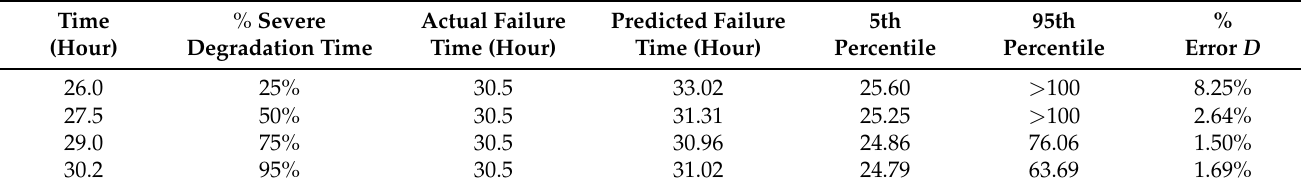
Table 2. TTF prediction results on bearing 3 in test 3 in the IMS dataset.